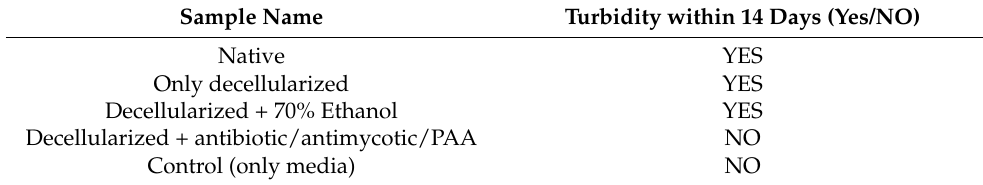
Summary of turbidity tests performed in native, only decellularized, and decel- lularized treated with 70% ethanol or antibiotics/antimycotics/PAA, compared with control group (only